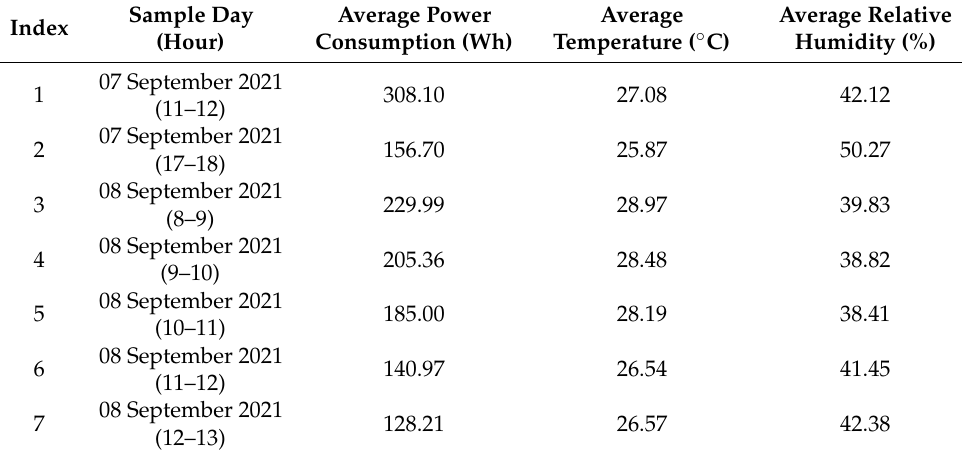
Table 7. Power consumption, temperature, and humidity of the HVAC equipment with the built-in control system with average operating temperature of 26.58 ◦